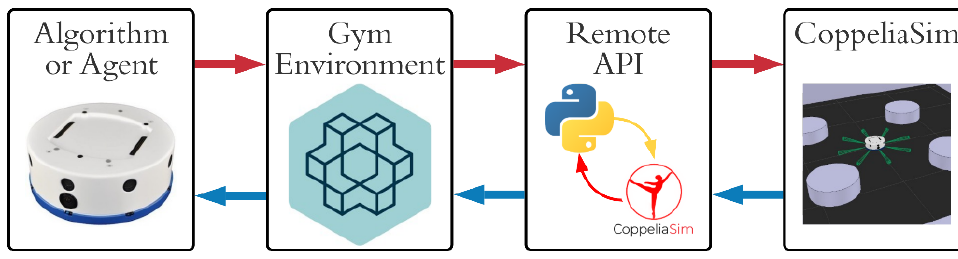
Figure 6. Communication diagram.